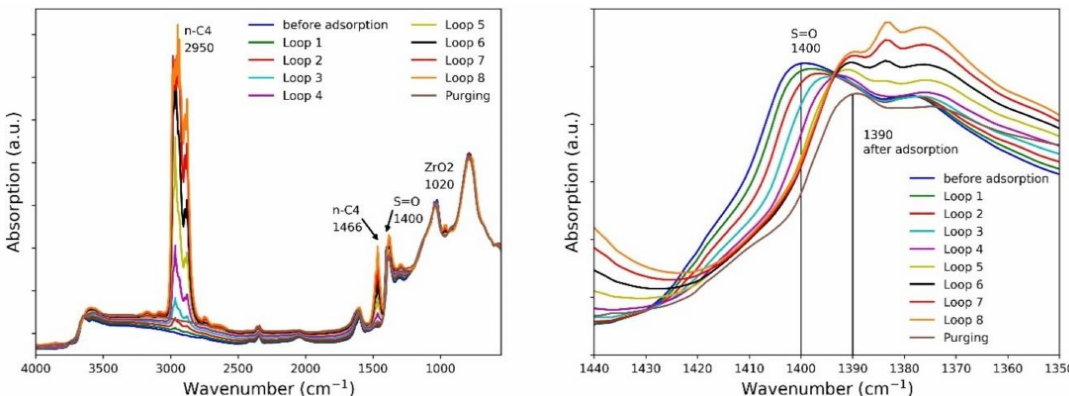
Figure 1. DRIFT spectra for adsorption of n -butane on sulfated zirconia at T = 308